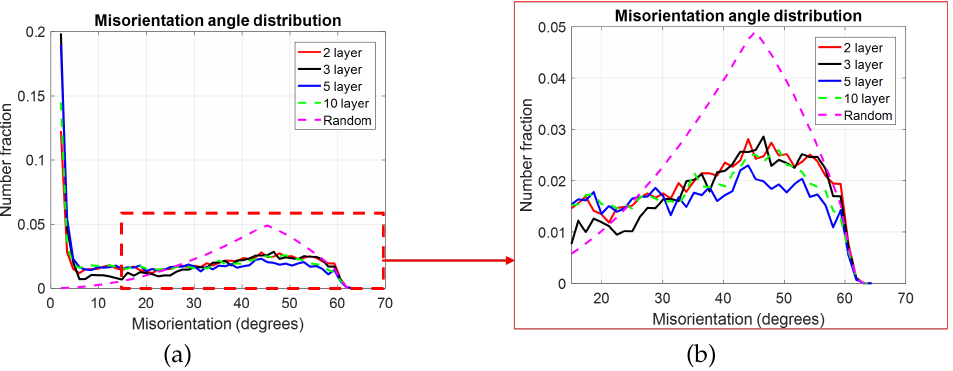
Figure 9. Analysis of the misorientation angle distribution of grains in the 2-, 3-, 5-, and 10-layer samples: ( a ) histogram of the number of the grains vs. the misorientation angle near the weld interface; ( b ) zoomed-in section with higher misorientation angles showing a peak for all the samples with similar distributions.